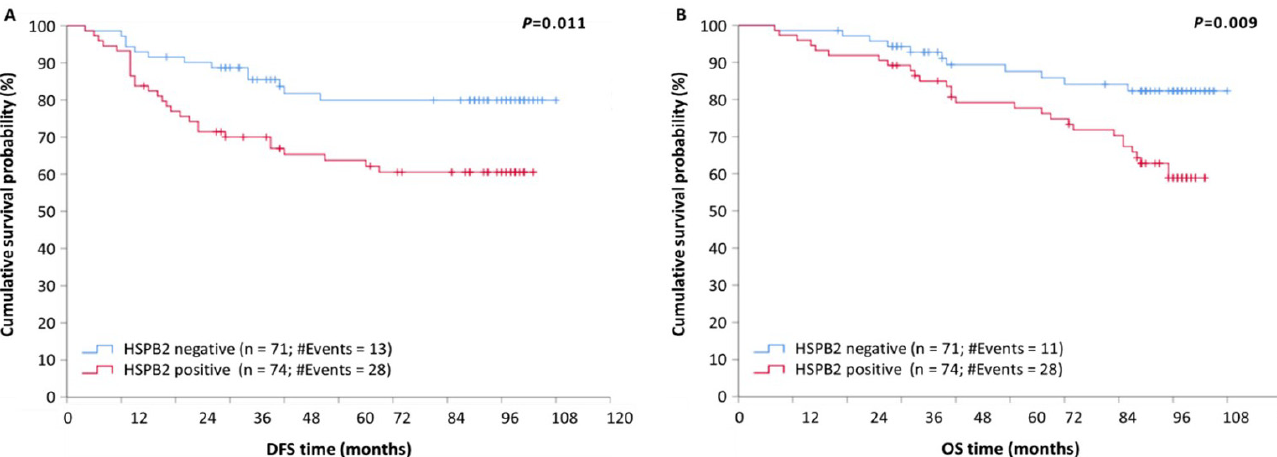
Table 4. HSPB2 mRNA expression status and overall survival (OS) of BrCa patients. Univariate Analysis ( n =